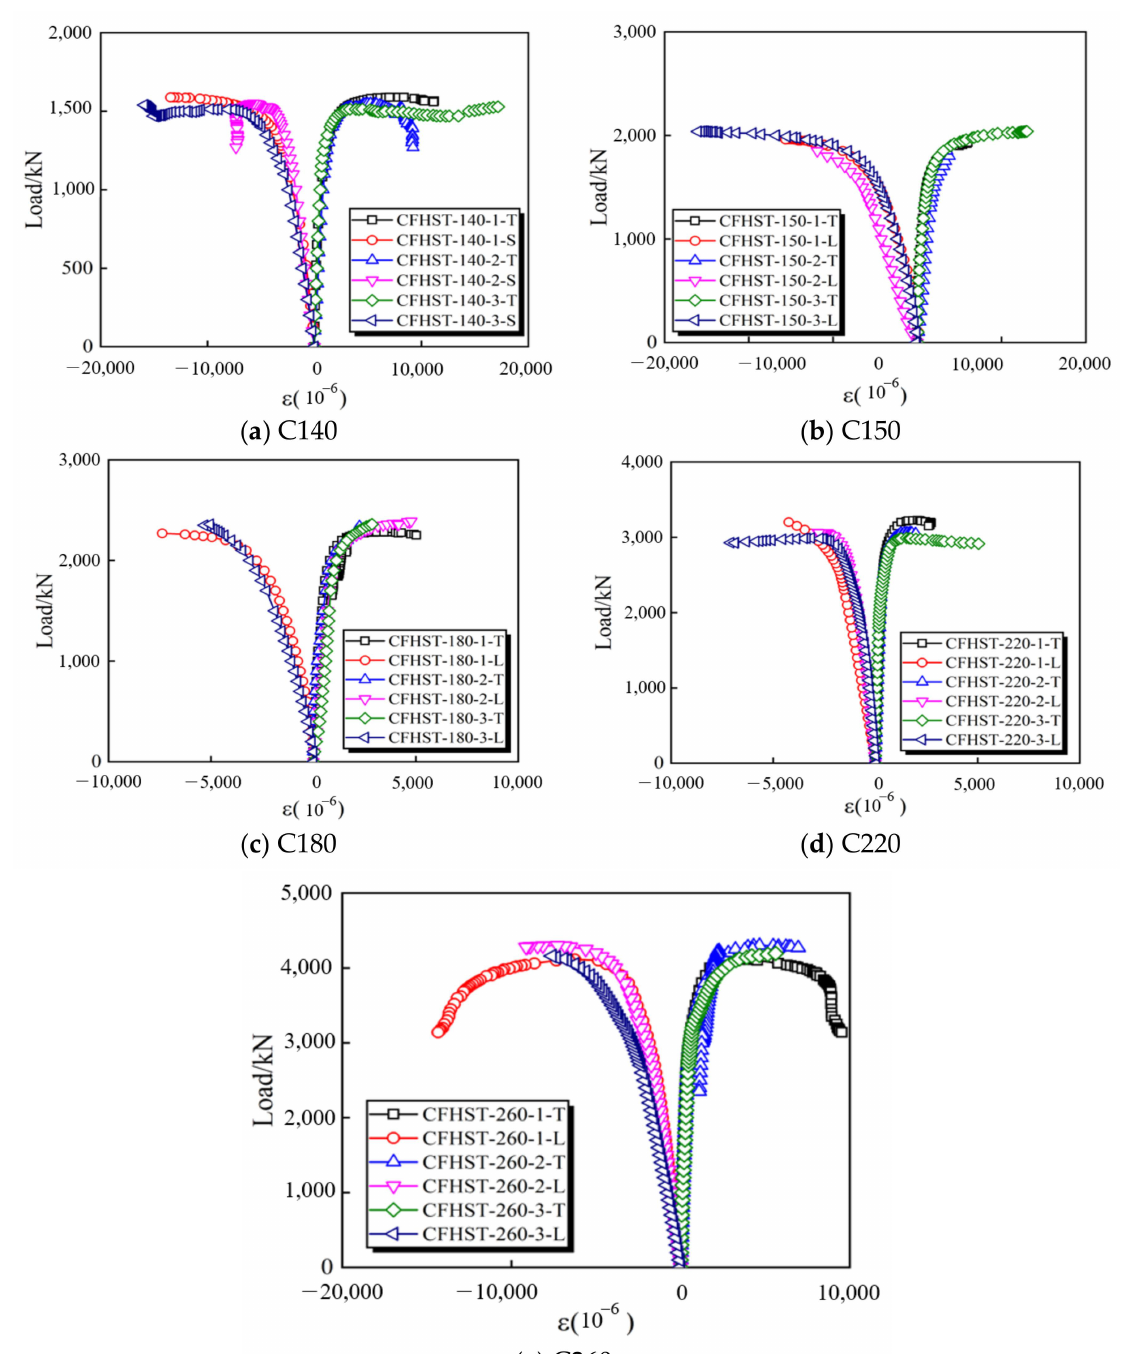
Figure 7. Load–strain curves of CFHST